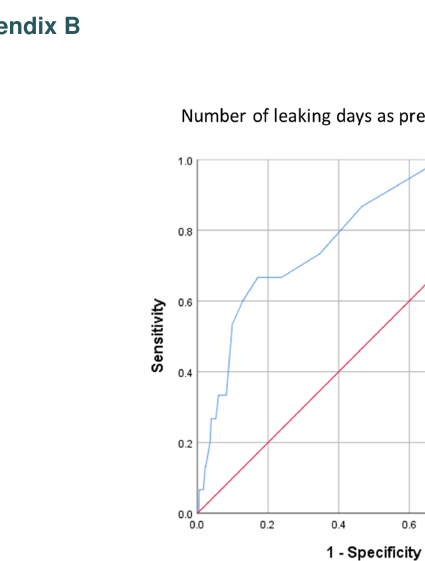
Figure B1. Receiver operating characteristic (ROC) curve using duration of leakage days or number of sent alerts as cutoff value for detecting